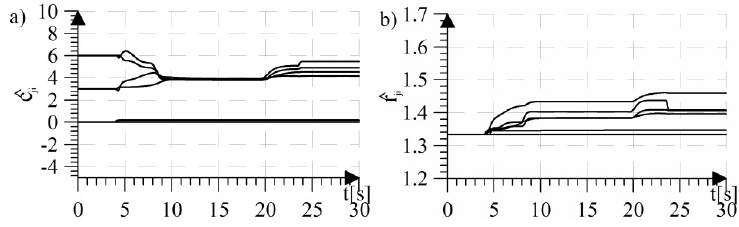
Figure 6: The course of learning the width and center of the Gaussian function located in the premises of the rule base.